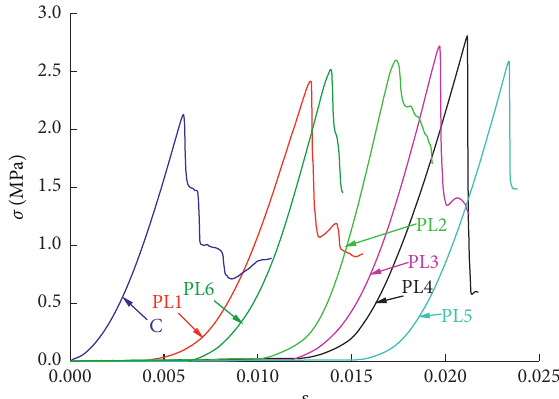
Figure 6: PL/SC splitting tensile strength stress-strain